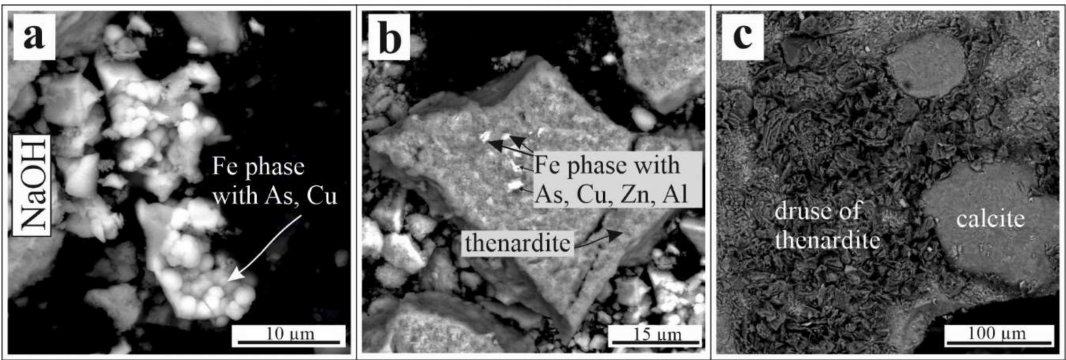
Figure 10. Scanning electron microscopy images of the precipitates after the experiments with NaOH: ( a ) colloforms of Fe minerals containing As (up to 3.2%) and Cu (0.34%); ( b ) fine-grained inclusions of Fe-minerals (presumably scorodite) in thenardite, with impurities of Cu (up to 0.4%), Zn (up to 0.53%), and Al (up to 1.6%); ( c ) calcite grains in a druse of thenardite.